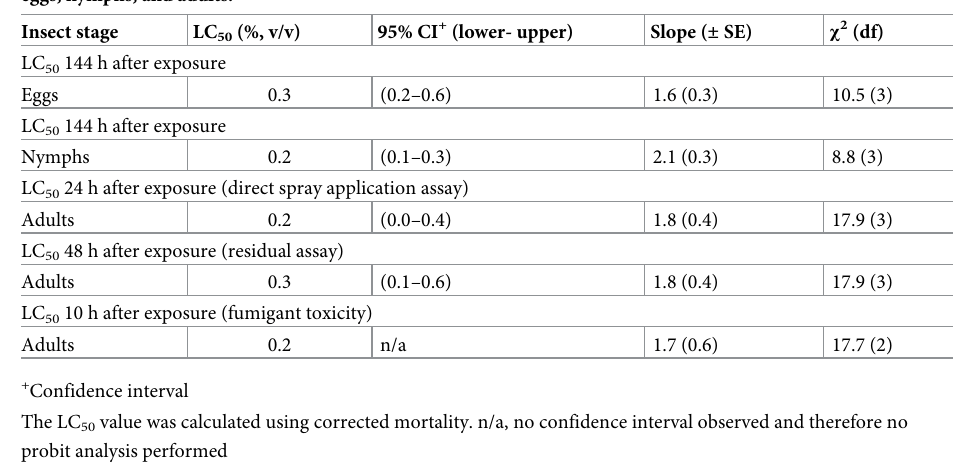
+ Confidence interval